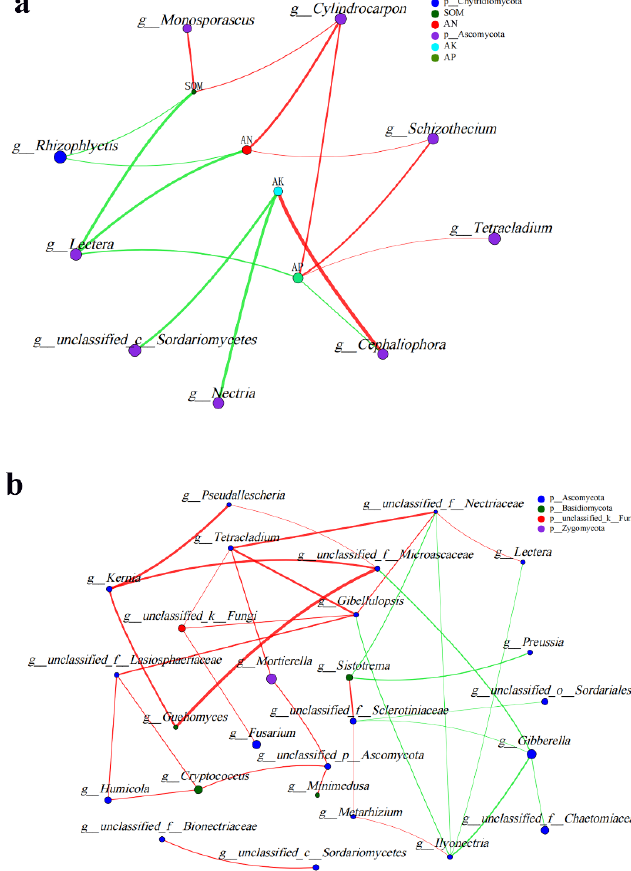
Figure 6. Correlation network analysis of fungal communities in soil samples of aged apple orchards. ( a ) Two-way network correlation analysis of environmental factors and total species abundance of the top 120 fungal genera; ( b ) Univariate network analysis among the top 30 fungal genera at the taxonomic level. The node size is directly proportional to environmental factors and species abundance. Nodes with different colors represent different species. The connecting line color indicates a positive or negative correlation: red indicates a positive correlation, and green indicates a negative correlation. The thickness of the connecting line indicates the magnitude of the correlation coefficient. The thicker the connecting line, the higher the correlation between species; more lines indicate a closer connection between the nodes.